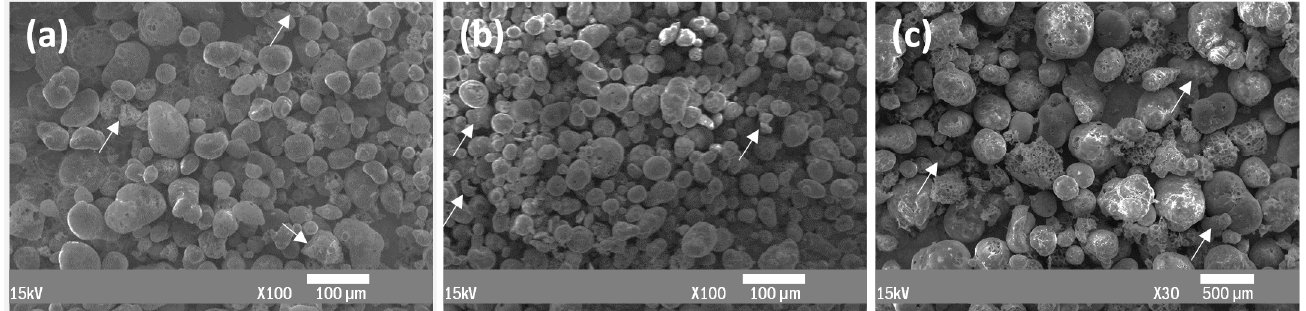
Figure 2. SEM images of three produced microsphere grades: F1 at 100× magnification ( a ); F2 at 100× magnification ( b ); and F3 at 30× magnification ( c ). The white arrows show non-expandable particles.